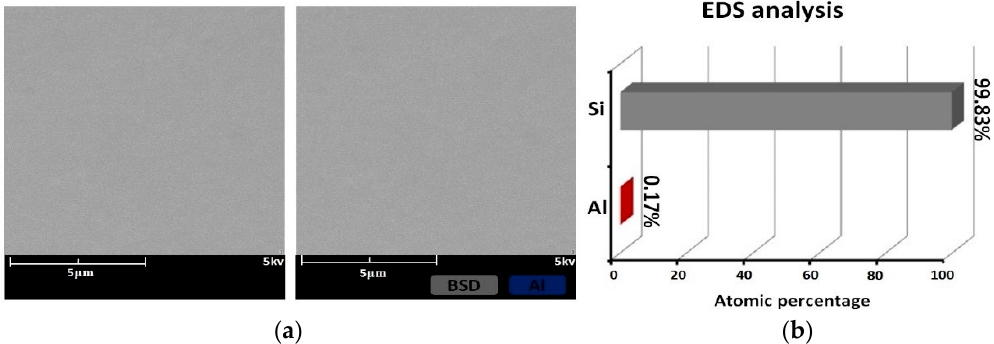
Figure 4. Sample #1 etched 100 nm depth in EJP processing: ( a ) morphology result and ( b ) EDS result.